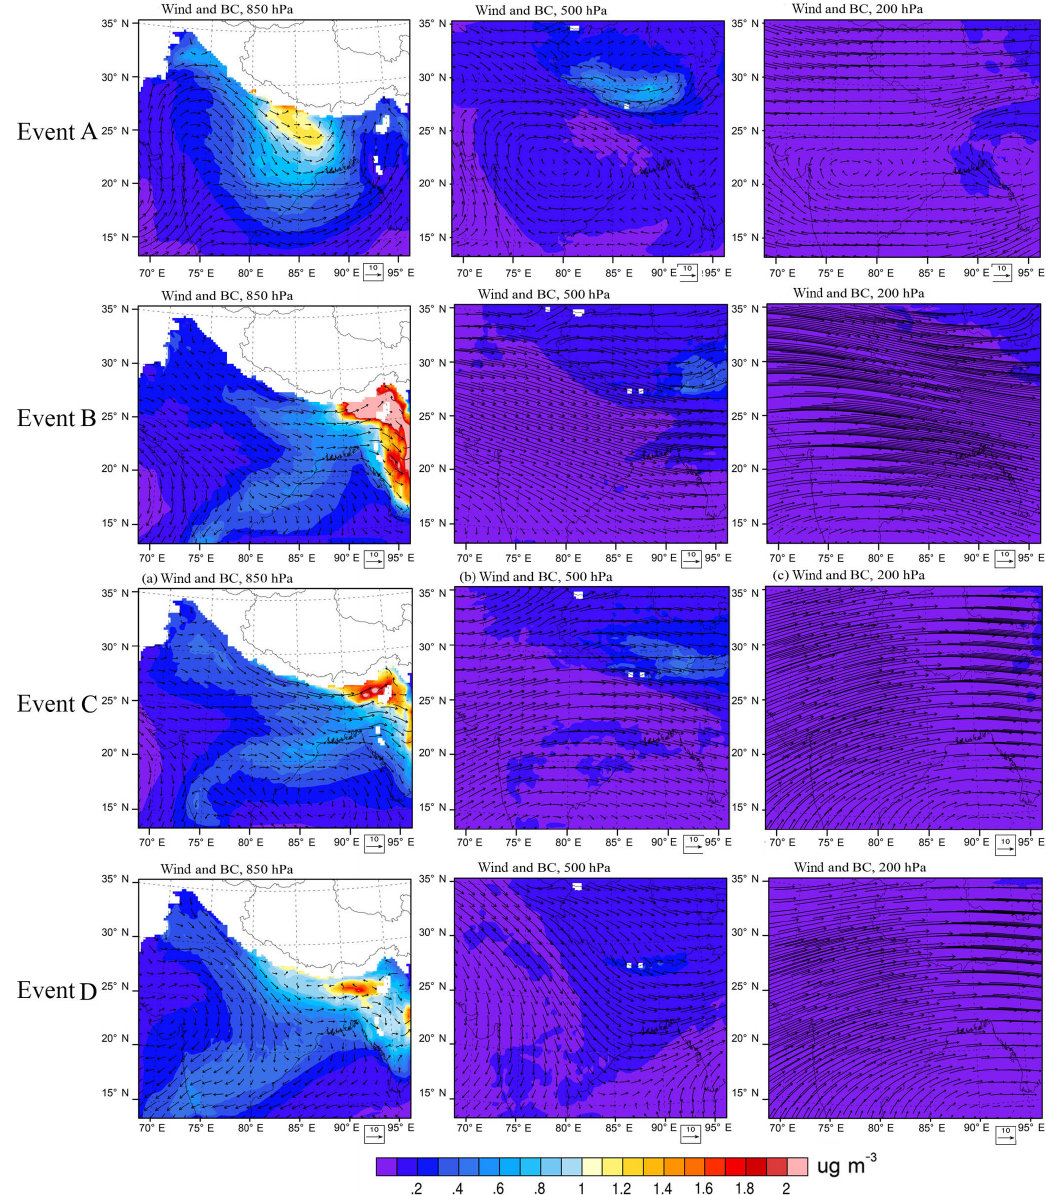
Figure 9. Mean BC concentration and wind at 850, 500, and 200hPa simulated by WRF-Chem model at QOMS and its vicinities: event A (the first row); event B (the second row); event C (the third row); event D (the last